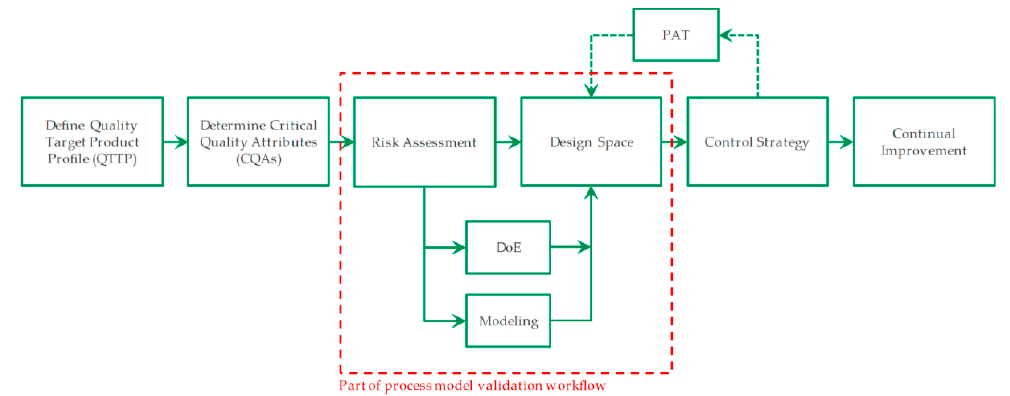
Figure 1. Workflow chart for process design with process modelling as its central part [26]. Reproduced with permission from A. Schmidt, Processes; published by MDPI, 2019. (With process analytical technology abbreviated PAT and DoE standing for design of experiments.).